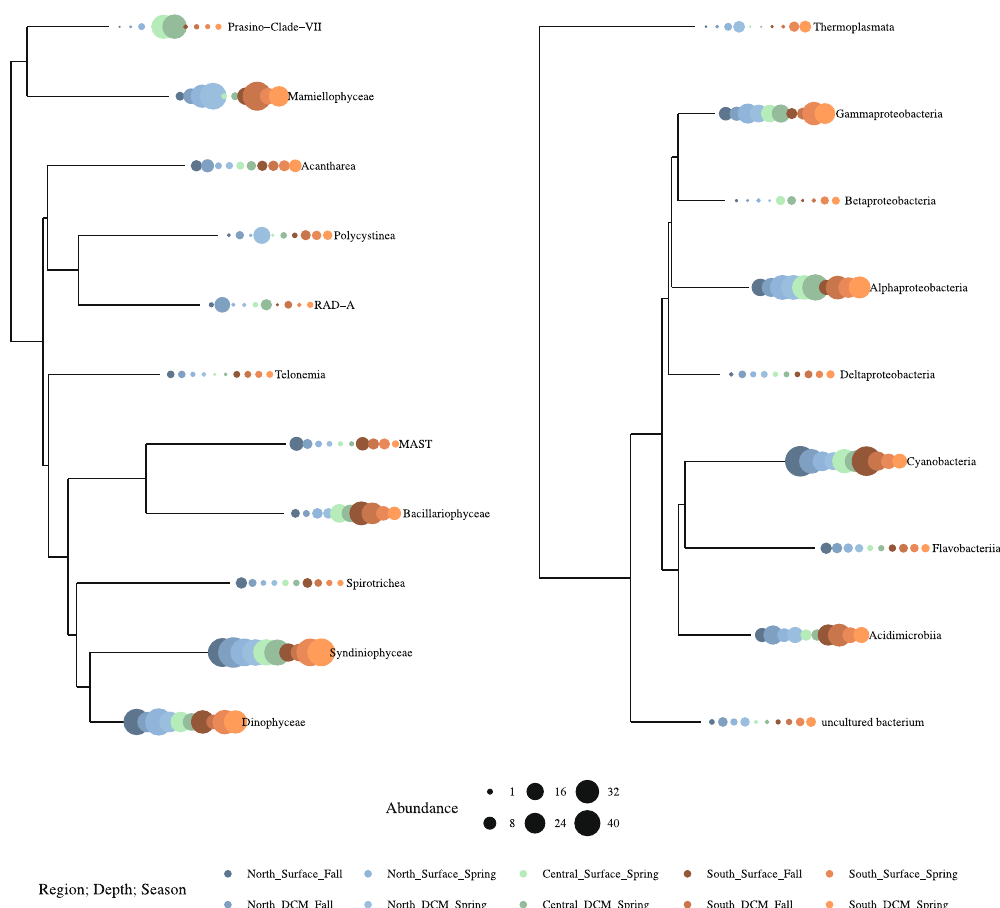
Figure 2. Phylogenetic tree of the main classes of ( a ) eukaryotes and ( b ) prokaryotes based on alignments of the 18 S rRNA and 16 S rRNA genes, respectively. The proportional abundance of specific classes in each regions (north, south), depths (surface, deep chlorophyll maximum – DCM), and seasons (spring, fall) (color coded) is denoted by the size of the circle at the end of each